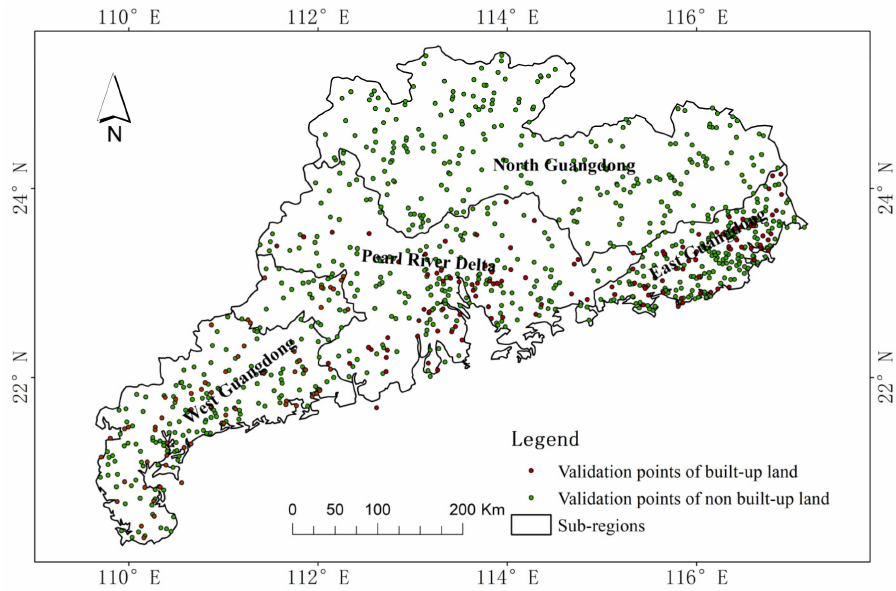
Figure 10. Spatial distribution of validation sample points.